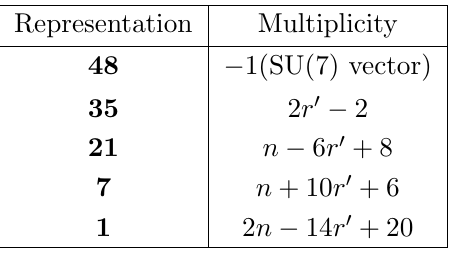
Table 2 . The spectrum for the con(cid:12)guration